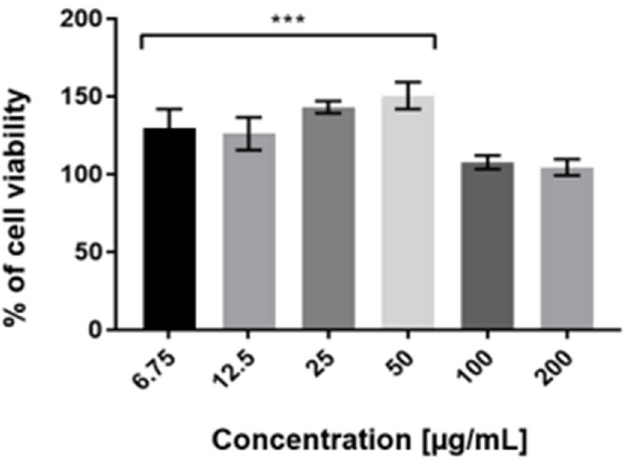
Figure 4. The effect of increasing concentrations of aqueous MAE Schisandra chinensis extracts (6.75, 12.5, 25, 50, 100, 200 µg/mL) on Neutral Red Dye uptake in cultured keratinocytes after 24 h of exposure. Data are the mean ± SD of three independent experiments, each of which consists of three replicates per treatment group. *** p < 0.001 versus the control (100%).